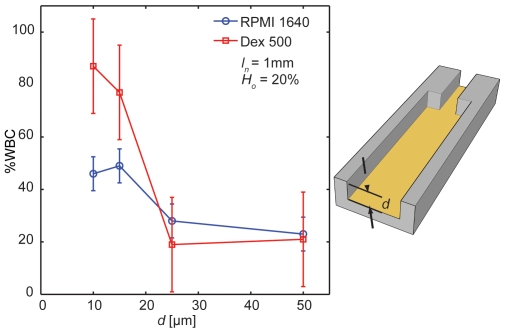
WBC margination varies with channel depth.As the depth of the device is increased above ∼20 µm, margination to the lateral side walls drops off dramatically. This is likely due to the fact that the WBCs are ∼10 µm in diameter, and when the channels exceed 20 µm in height, they are no longer confined to a pseudo-2D geometry. Thus, in higher channels, there is likely margination to all 4 channels walls rather than just the two lateral walls seen in channels with small height.